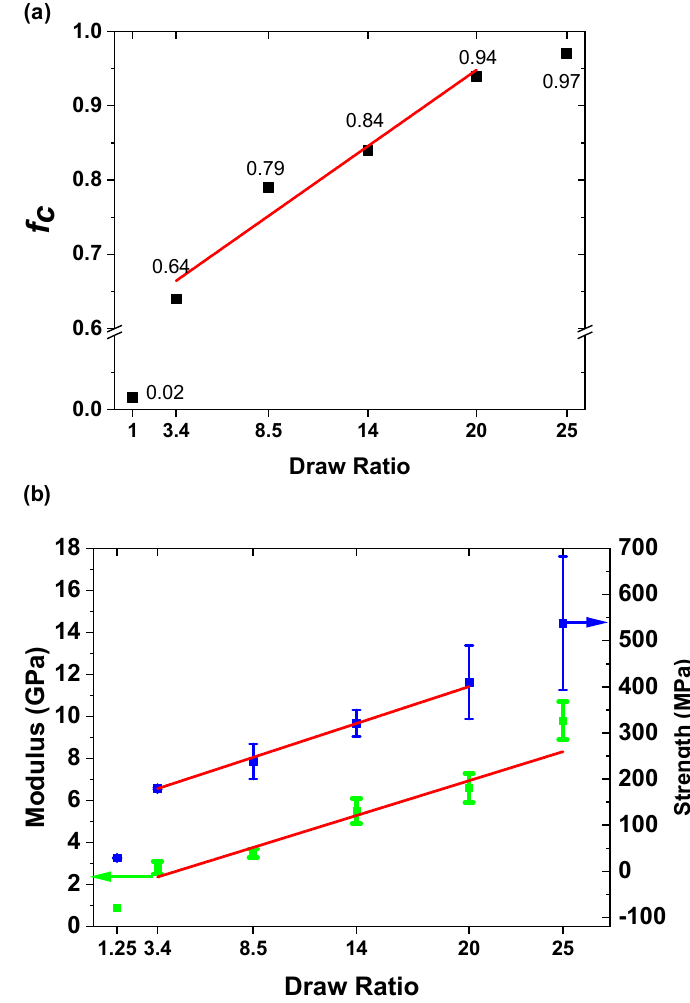
Figure 11. ( a ) Herman’s orientation factor as a function of draw ratio; ( b ) modulus as a function of draw ratio (green) and tensile strength as a function of draw ratio (blue). The mean and standard deviation data are based on the average of five experiments.